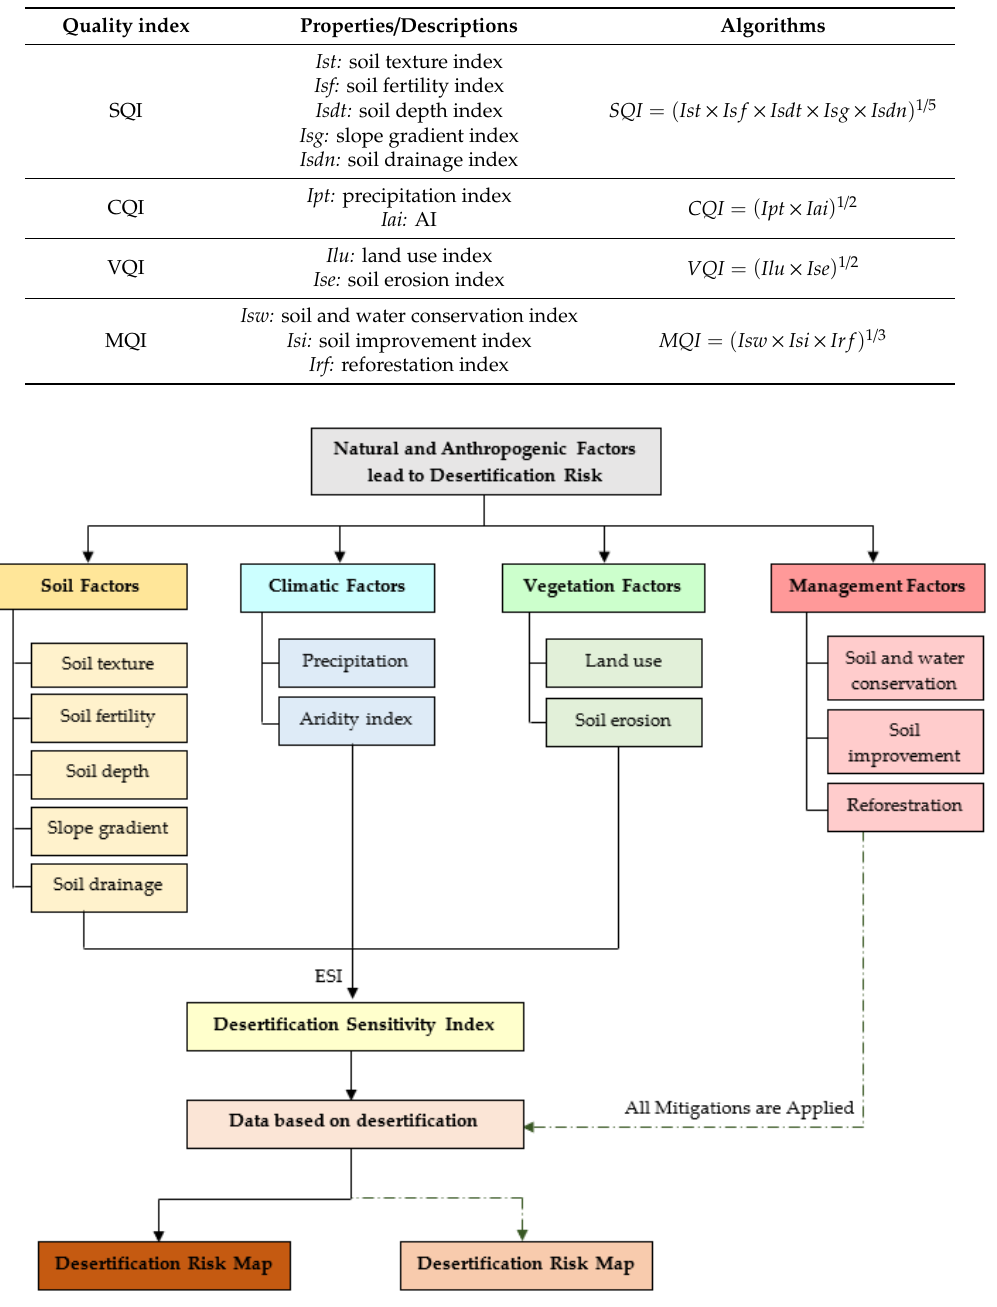
Figure 2. Methodology approach.